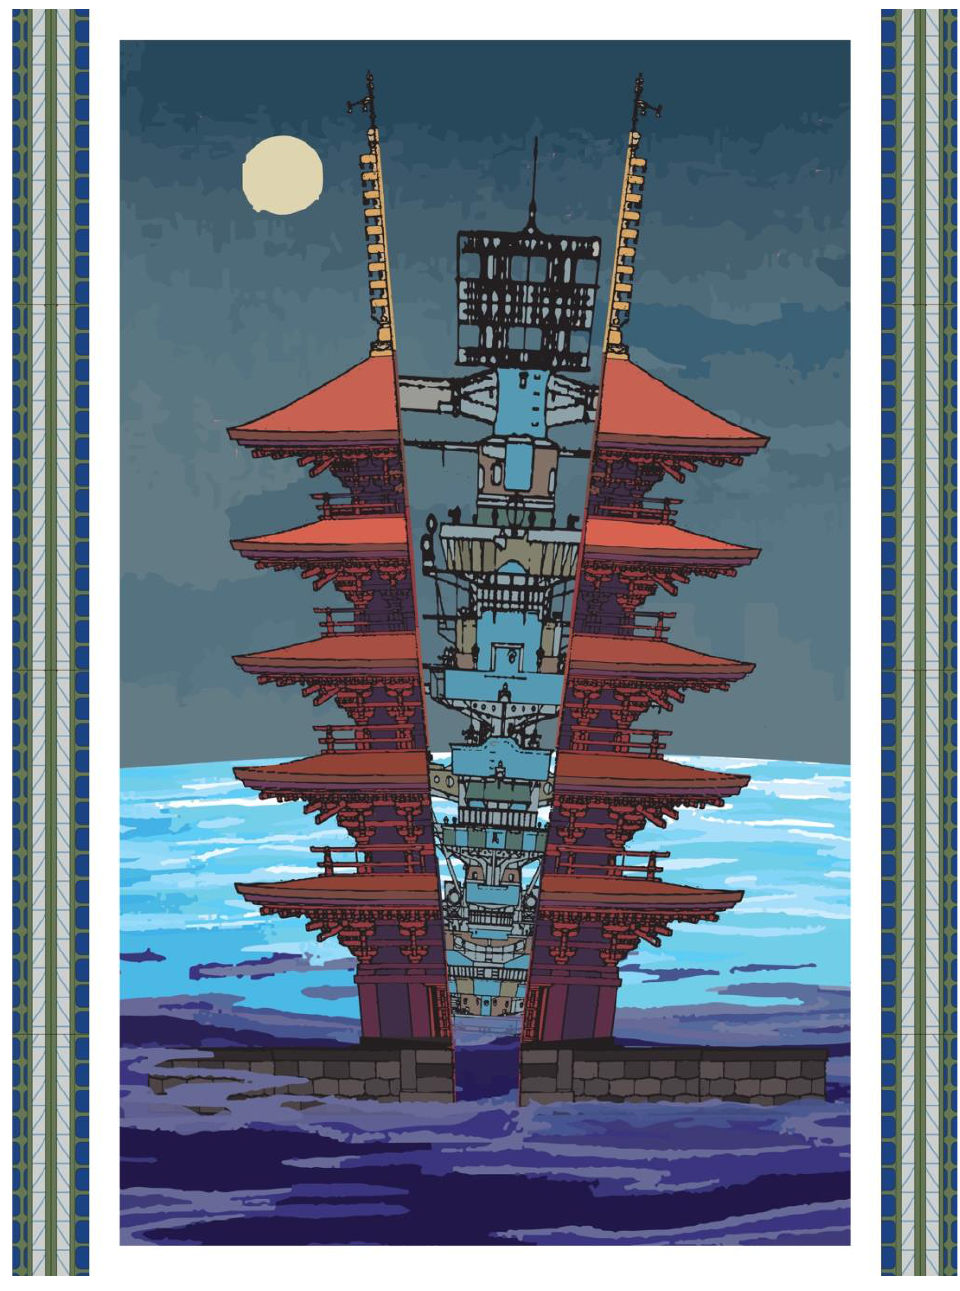
Kio Griffith, Eight Views of the Sun Setting on the South Pacific / Five Story Pagoda , 2020. Digital collage print on